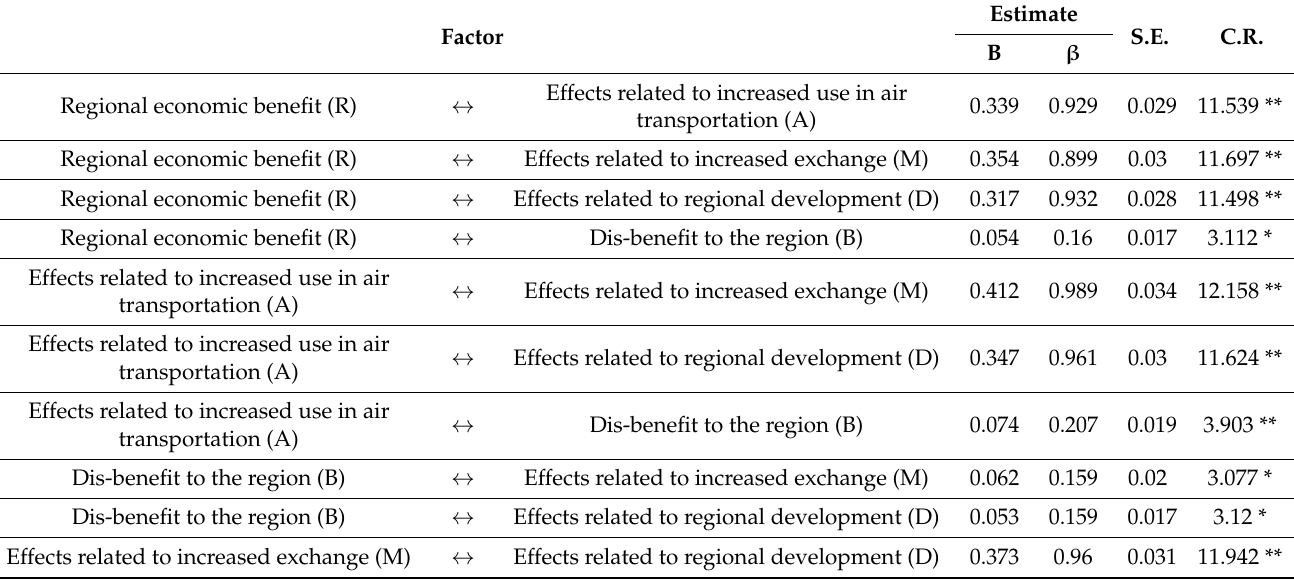
Table 4. Analysis of Structural Model path per